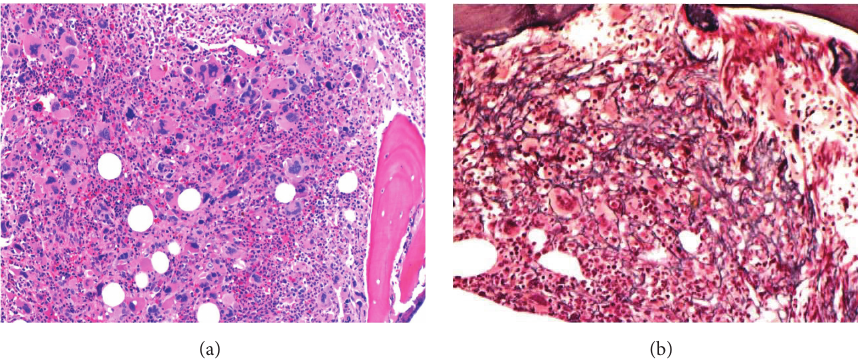
Figure 2: (a) Postinduction bone marrow biopsy showing 95% cellularity with granulocytic hyperplasia and numerous large, hyperlobulated megakaryocytes with clustering. (b) Reticulin stain of the postinduction bone marrow showing significantly increased reticulin fibrosis (3/4).